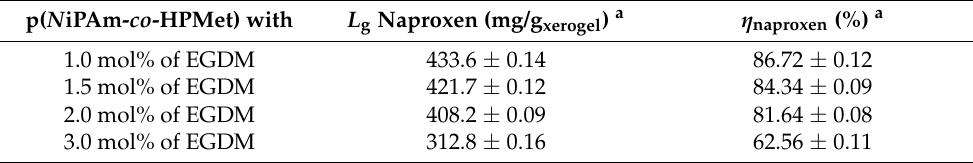
Table 6. The Mass of Incorporated Naproxen ( L g ) into the Co-Hydrogels and Naproxen Incorporation Efficiency ( η naproxen